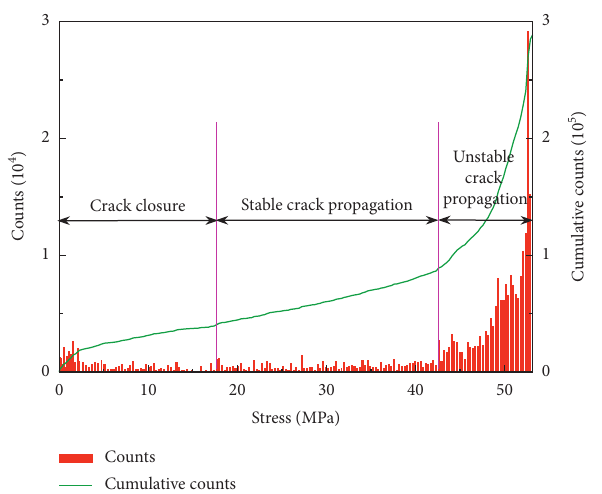
Figure 2: Relation between counts, cumulative counts, and stress.